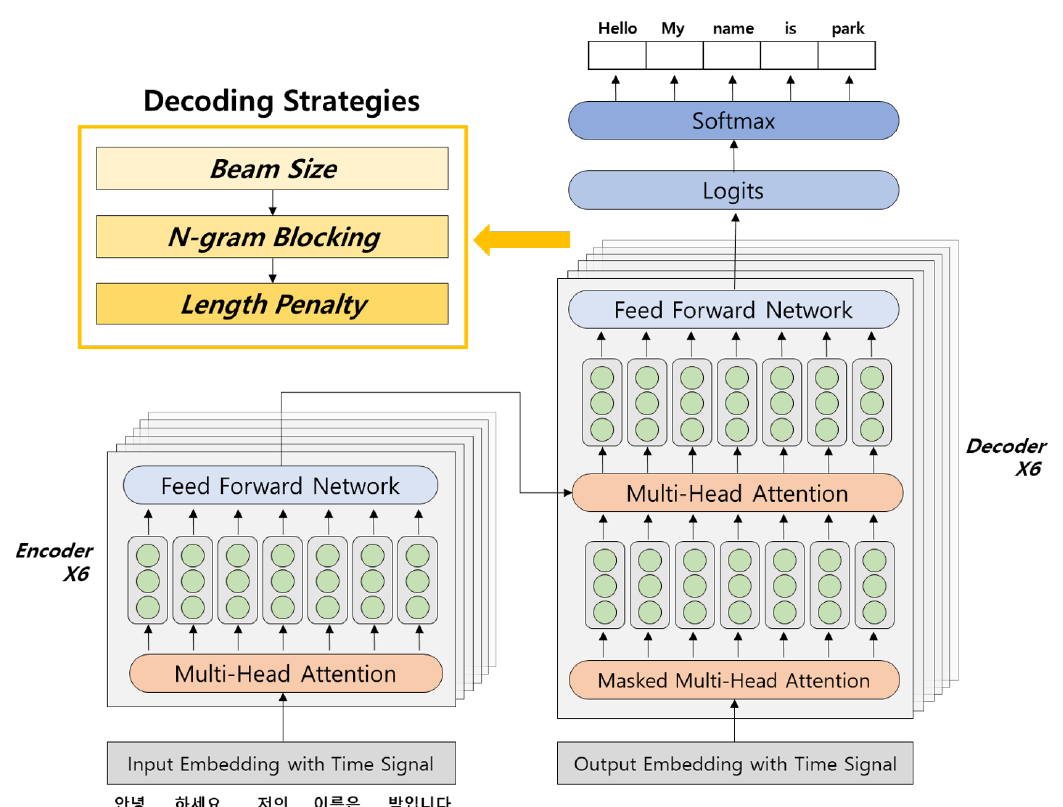
Figure 1. Overall architecture of the Korea University (KU) model using various decoding